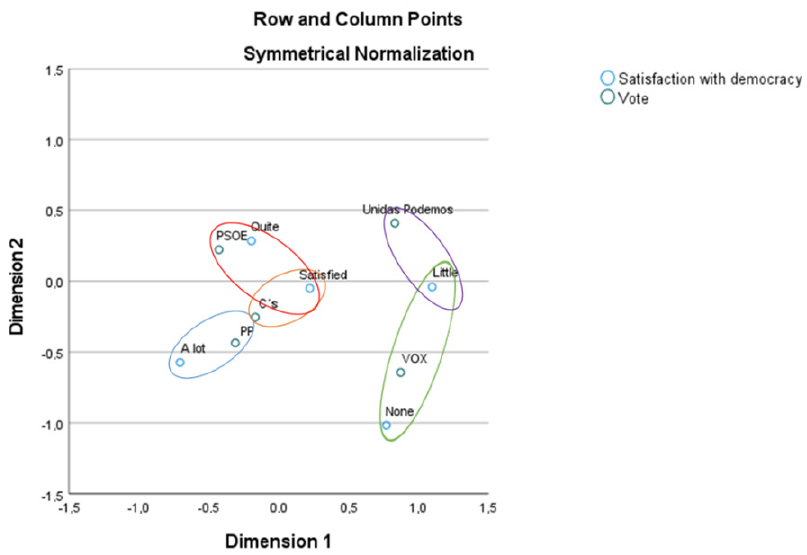
Figure 1. Correspondence analysis of the level of satisfaction with democracy compared to the recall of vote choice in the November 2019 general election. Source: authors’ own creation based on the data of the post-electoral study of the November 2019 general election conducted by Political Research Team.